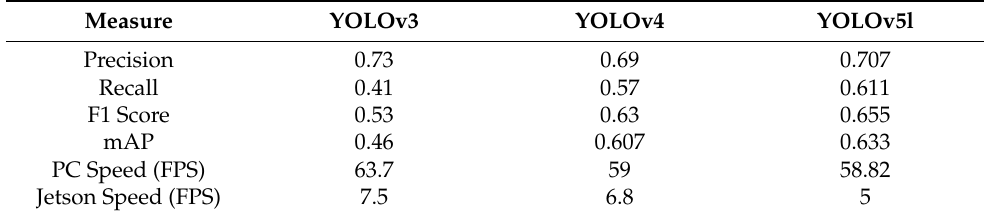
Table 3. Results of comparing YOLOv3, YOLOv4 and YOLOv5l algorithms for emergency landing spot